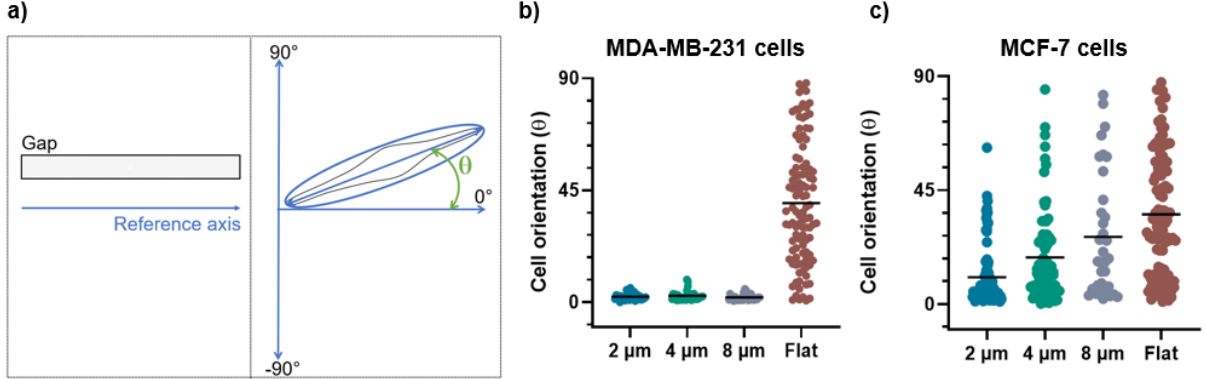
Figure 5. ( a ) The schematic representation of the orientation angle as a function of cells’ positioning along the micro-gaps. After indicating the reference axis as parallel to the major axis of the micro-gap (on left), the cell orientation was calculated as the angle between the major axis of the cell and the reference axis (on right). ( b ) Orientation angles for MDA-MB-231 cells on 2 µ m (n = 95), 4 µ m (n = 78), and 8 µ m (n = 52) wide micro-gaps and on flat membranes (n = 150). ( c ) Orientation angles for MCF-7 cells on 2 µ m (n = 94), 4 µ m (n = 73), and 8 µ m (n = 36) wide micro-gaps and on flat membranes (n = 101). All data plotted are the absolute values of the evaluated angles. The black line is the mean value for each data